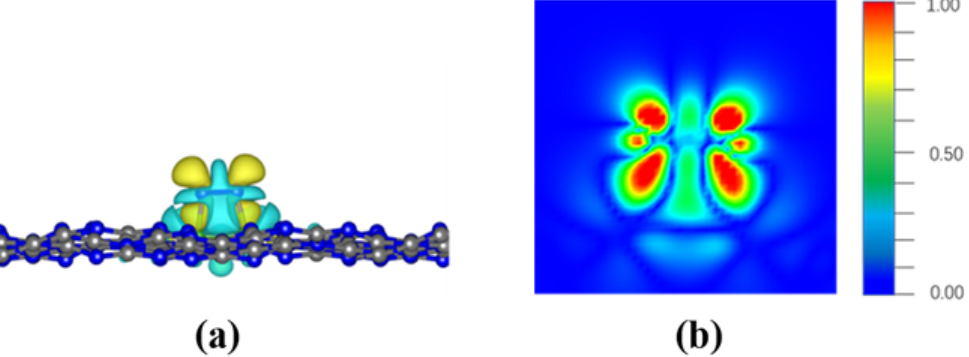
Figure 3. ( a ) Charge density differences (CDD) between N 2 and B2@C 3 N 4 ( b ) Plots of electronic localized function (ELF) N 2 on B2@C 3 N 4 . The red region indicates a high local electron distribution, the green region represents electronic-gas-like pair probability and the blue region shows a high electronic delocalized distribution.